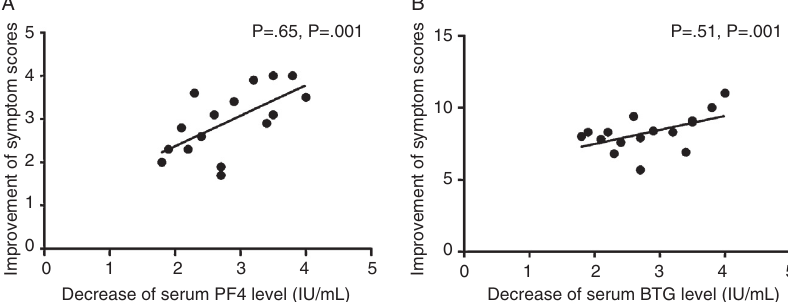
P=.65, P=.001 P=.51, P=.001